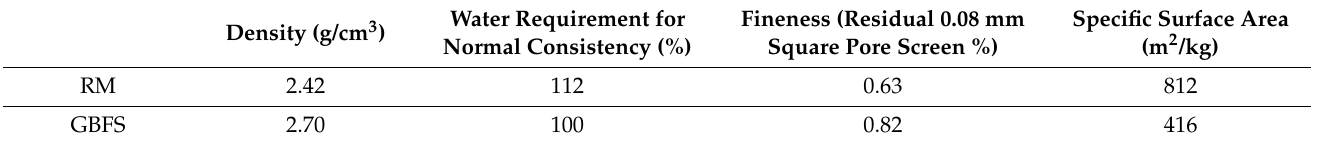
Table 2. Basic physical properties of RM.